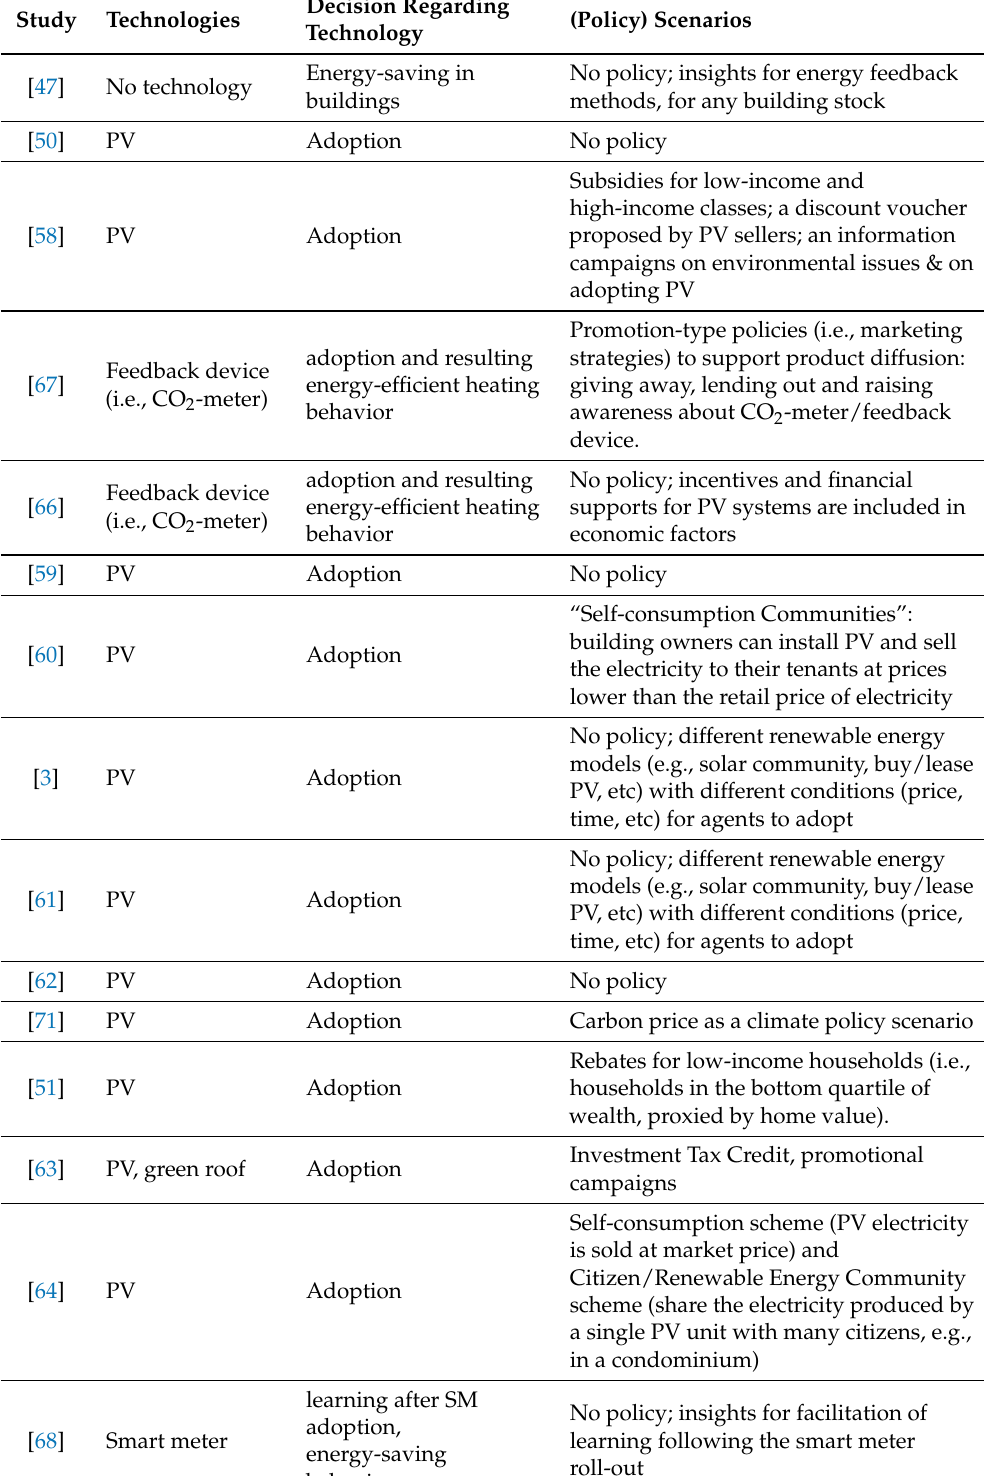
Table A2. Technologies and policy scenarios modelled using